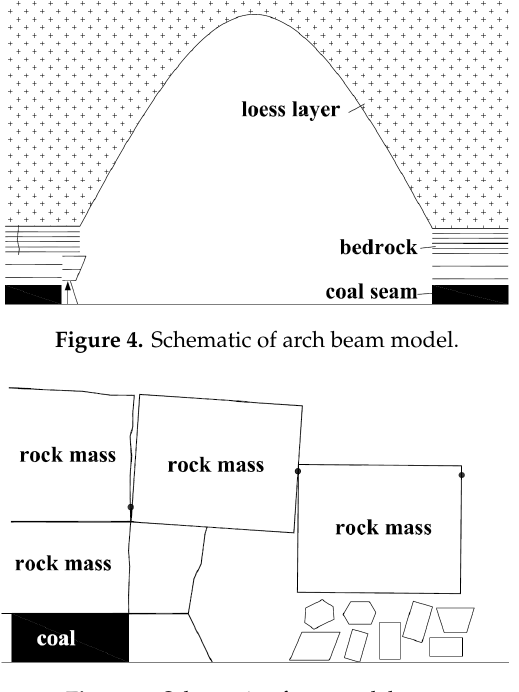
Figure 5. Schematic of step rock beam.